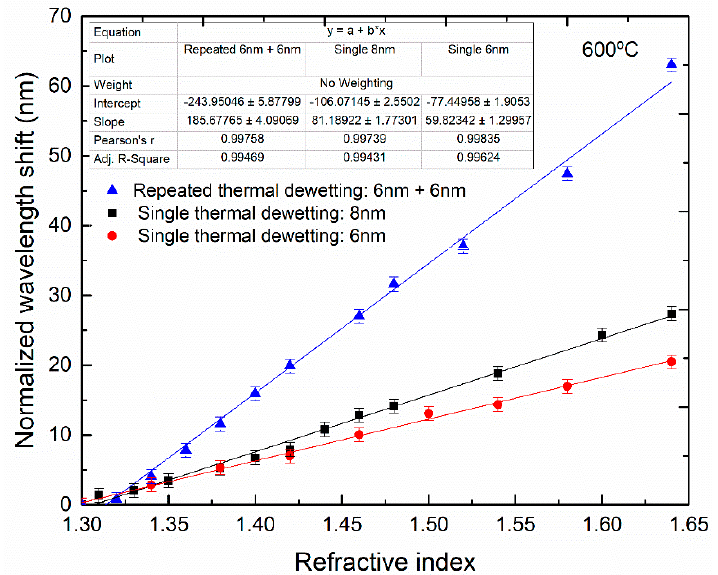
Figure 12. Calculated normalized wavelength shift as a function of the surrounding refractive index from 1.30 to 1.64 of multimode silica optical fibers coated with a 6 and 8 nm of gold and fabricated at